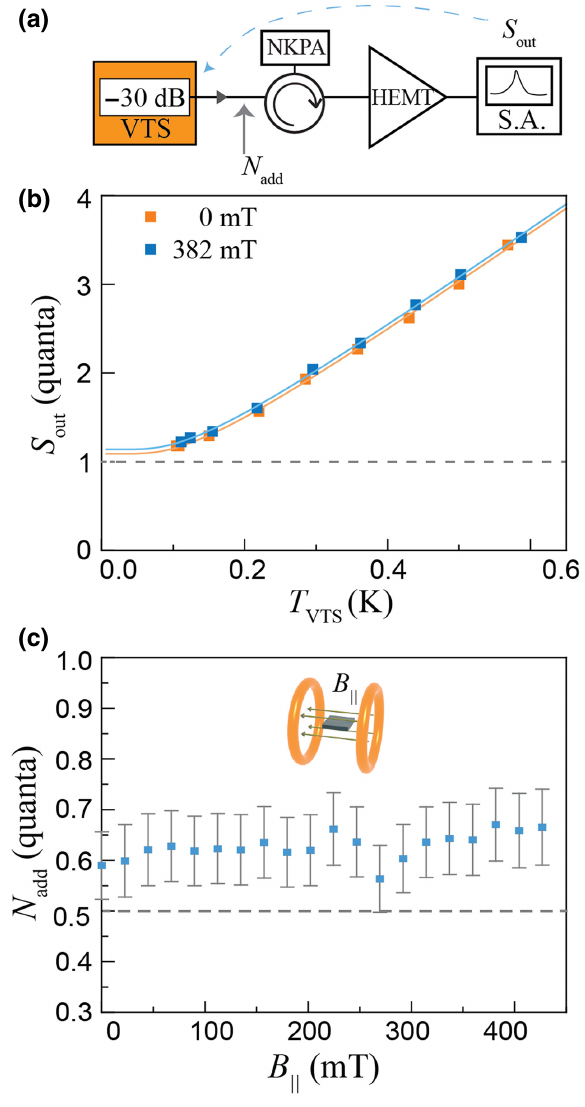
FIG. 3. (a) Noise thermometry calibration setup diagram. HEMT stands for high-electron-mobility transistor, which is a secondary amplifier. KPA is operated with 26-dB gain during the calibration. The blue dashed arrow indicates that all output noise power spectral density S out numbers quoted in this paper are referred back to the output of VTS. (b) Output noise power spectral density S out as a function of the thermal source temper- ature. Dashed horizontal line marks the standard quantum limit of phase-preserving amplification. (c) The added noise N add as a function of the in-plane magnetic field B ||